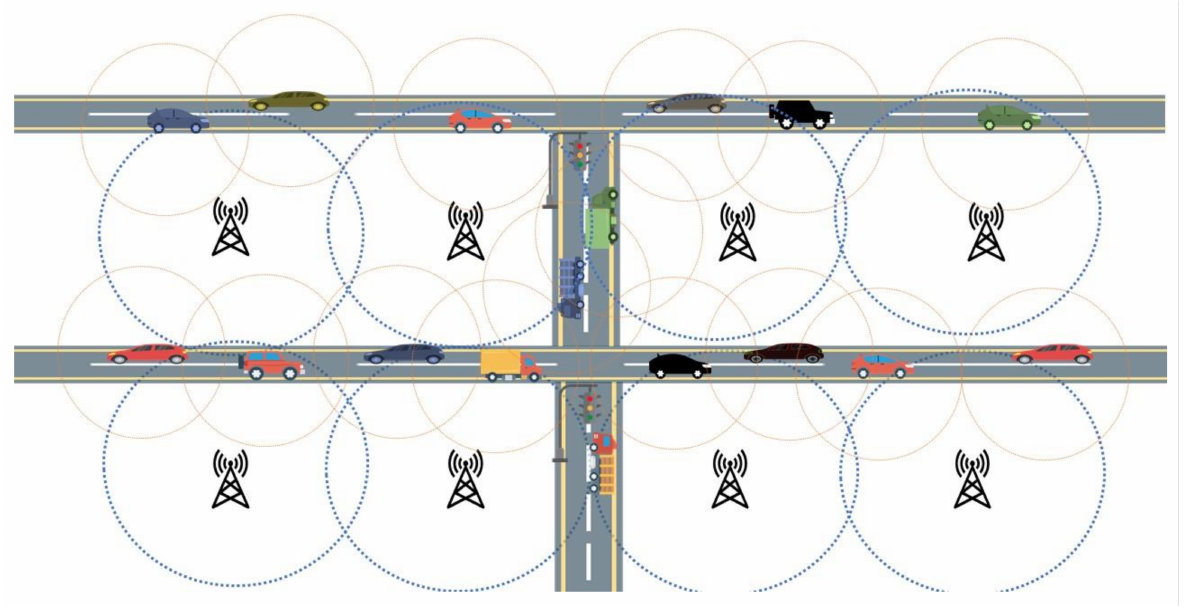
Figure 6. An urban/semi-urban environment, with communication ranges of SVs and road side units (RSUs).